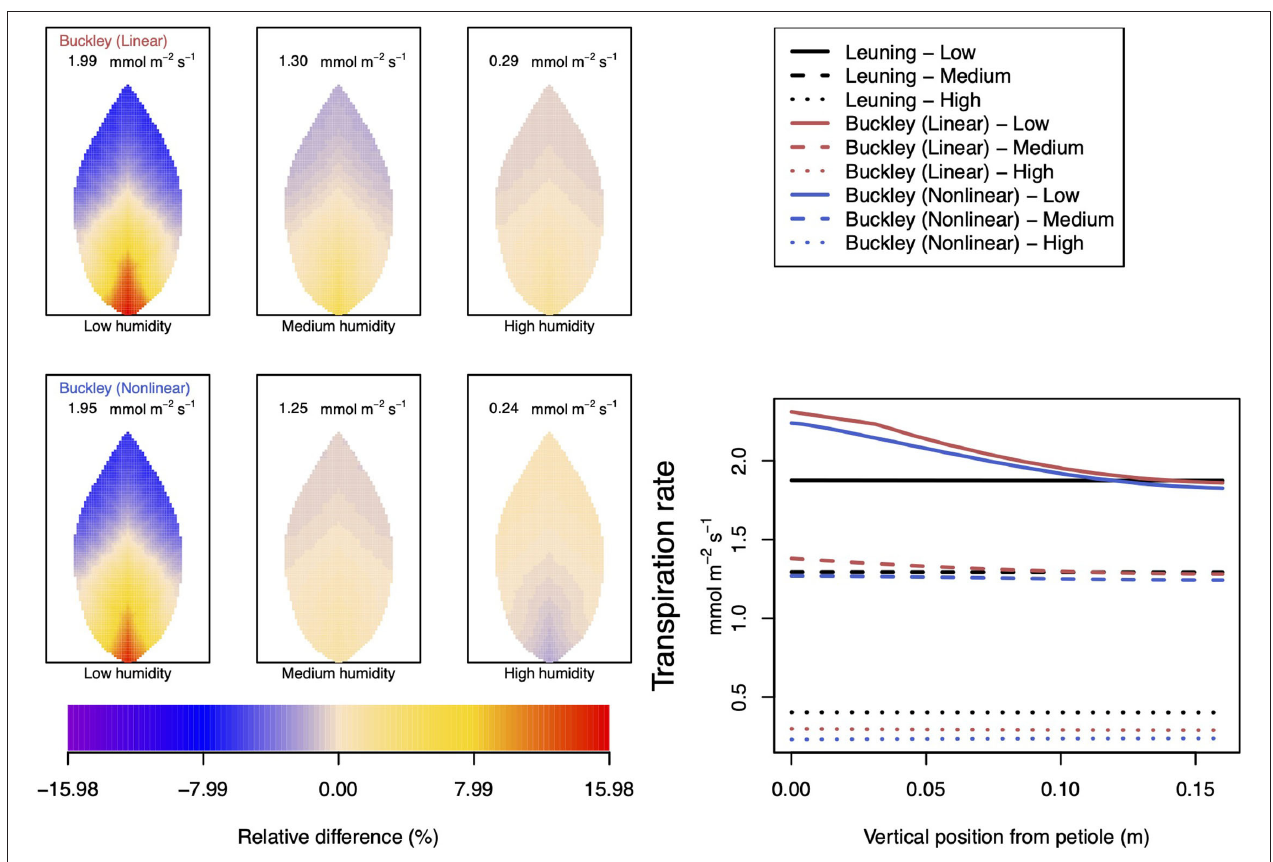
FIGURE 8 | A comparison of predictions of transpiration rate ( − F T ) distributed over the leaf according to the three stomatal conductance models of Leuning (1995) (black lines in right hand figure), linear (Buckley et al., 2003) (top row of panels and red lines in the right hand figure), and nonlinear (Buckley et al., 2003) (bottom row of panels and blue lines in right hand figure). The 2D maps shown are deviations from leaf-area averages. The leaf-area average values of transpiration rates are given at the top of each panel. The three columns (left-to-right) and line styles (solid, dashed, and dotted) show the respective dependencies on the atmospheric relative humidity : low (10%), medium (50%), and high humidity (90%). For the Leuning (1995) model, the uniform predictions equal the leaf-area transpiration averages of 1.87, 1.29, and 0.4 mmol m − 2 s − 1 under low, medium, and high humidity, respectively (2D heat maps are not shown). Other model parameter values can be found in Supplementary Information I . Note that the transpiration rates are represented as − F T for easy